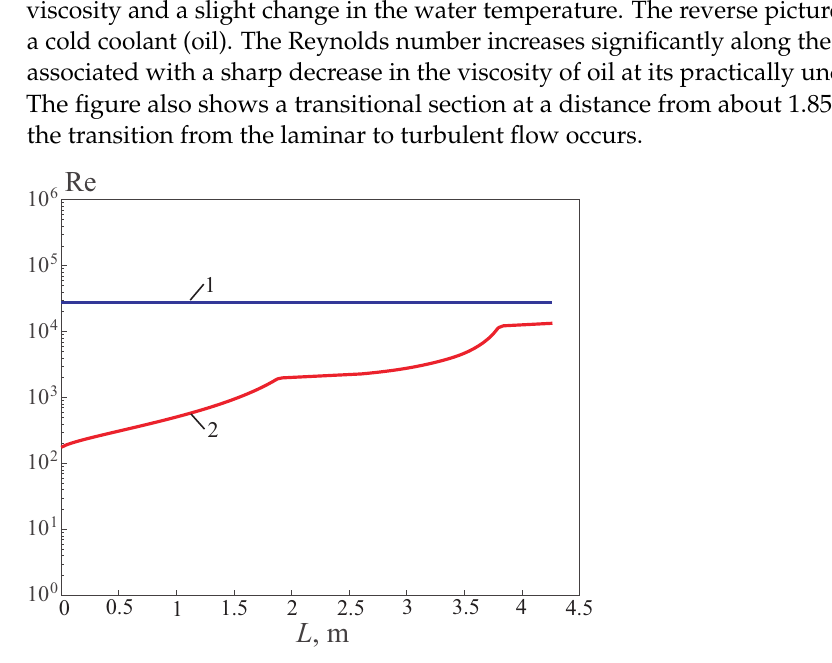
Figure 8. Distributions of Reynolds numbers obtained in a theoretical calculation. Line 1 corresponds to water, and line 2 corresponds to